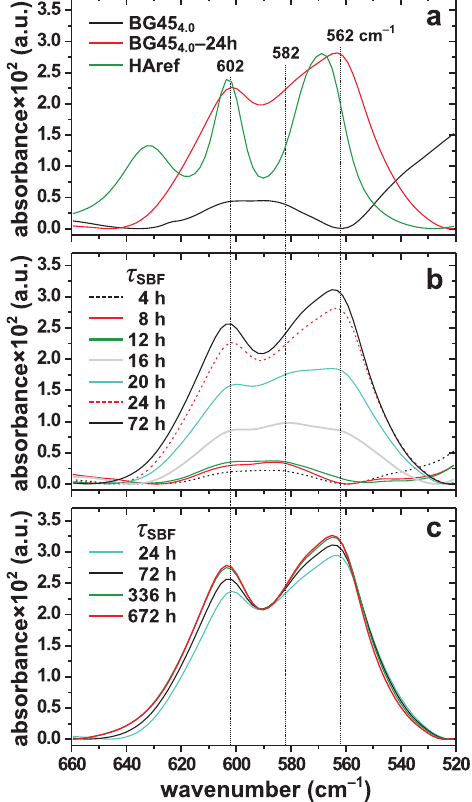
Figure 2. ( a ) FTIR spectra recorded from the BG45 4.0 glass powder before and after SBF exposure for 24 h, shown together with the results from a highly crystalline hydroxyapatite reference powder (HAref); the relative intensities are plotted in arbitrary units (a.u.). The spectra are zoomed over the wavenumber range relevant for discriminating IR responses from PO 3 − groups in disordered (BG45 4.0 ) 4 and ordered (BG45 4.0 –24 h and HAref ) structural environments. ( b , c ) FTIR spectra from BG45 4.0 – τ SBF glass powders exposed to SBF for the as-indicated τ SBF periods. Note that the data are normalized relative to the integrated intensity of BG45 4.0 –72 h in ( b ), but to equal spectral intensities at 590 cm − 1 in ( c ) to better convey the more pronounced band splitting that develops for increasing τ SBF